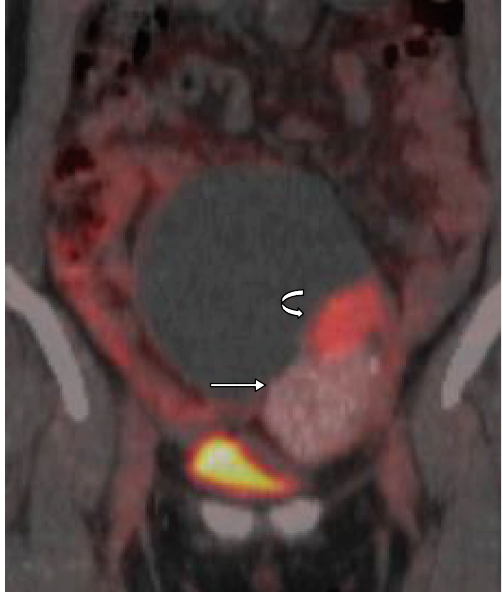
Figure 2: Coronal fused PET/CT image of the borderline Brenner tumor. The PET/CT shows a mild FDG uptake (SUVmax: 2.3) and calci fi cation in the solid component (arrow), and moderate FDG uptake (SUVmax: 5.8) in the papillary tumor (curved